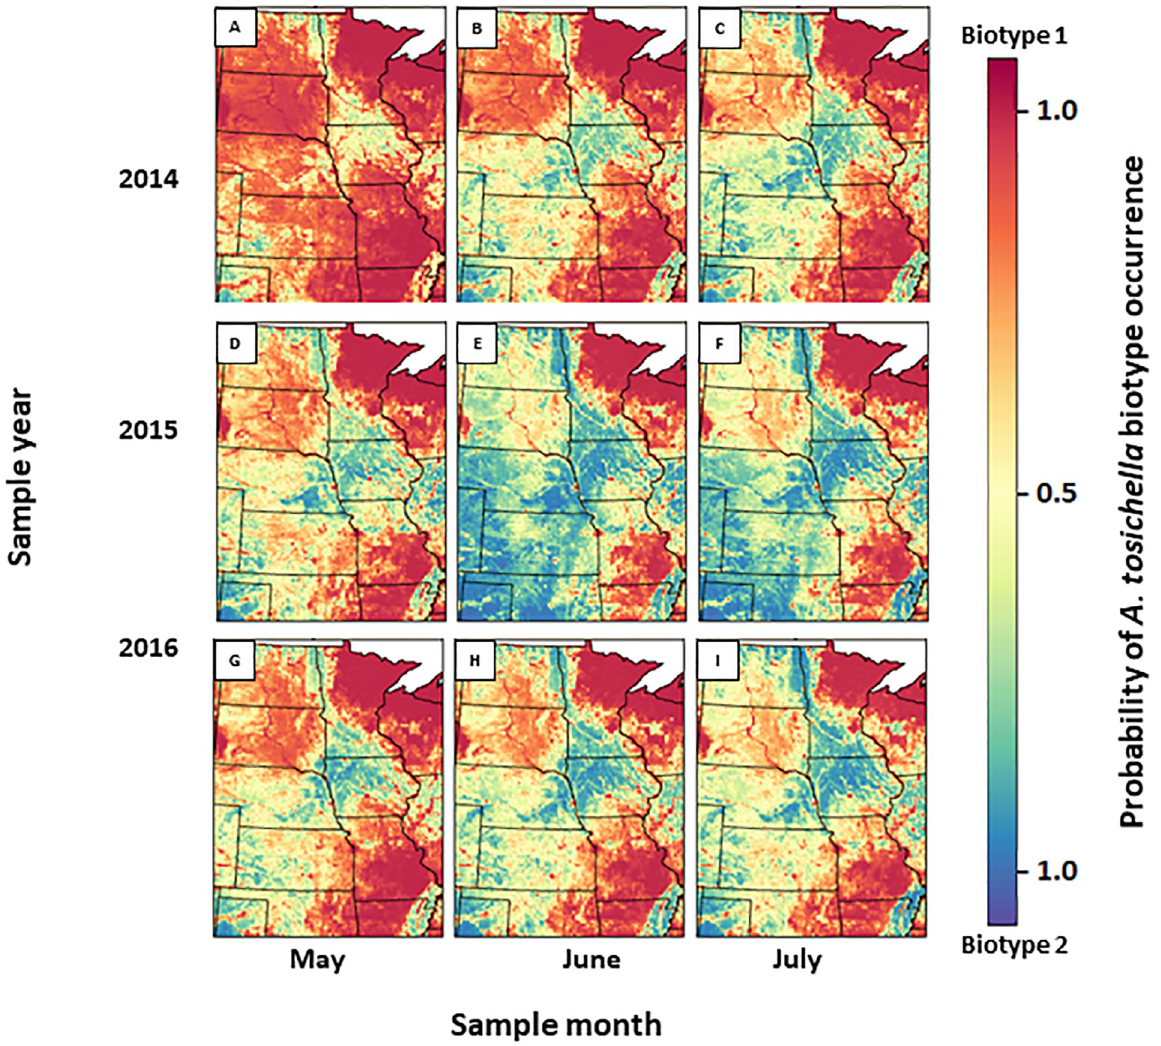
Fig 4. Predictive spatio-temporal heatmaps of the expected probability of A . tosichella biotype 1 and 2 in May, June and July of 2014, 2015 and 2016 as affected by increased precipitation 30 d prior to sampling and grass/pasture:cropland landcover ratio. Maps do not consider specific agricultural landscape and can be interpreted as the potential number of biotype 1 or 2 expected if a given map location was wheat. Red areas—higher probability of biotype 1 presence; blue areas—higher probability of biotype 2 presence. Note: These data were collected during the periods May 21 to July 10, 2014; June 25 to July 12, 2015; and June 245 11 to June 16, 2016. As a result, the predictive maps are an extrapolation if used to infer dynamics outside of the time periods in which these data were collected.